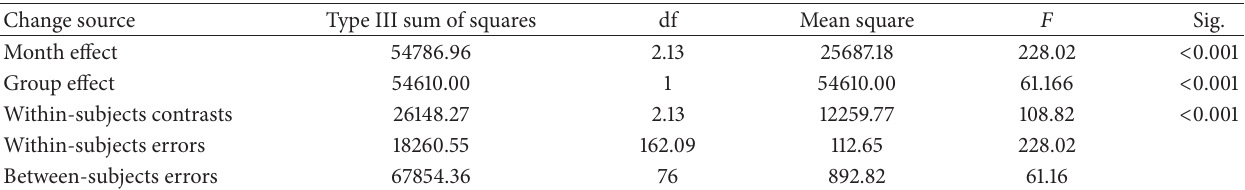
Table 3: ANOVA test for comparisons of changes in self-care before the intervention and during the first, second, and third months after the intervention in the intervention and control groups.